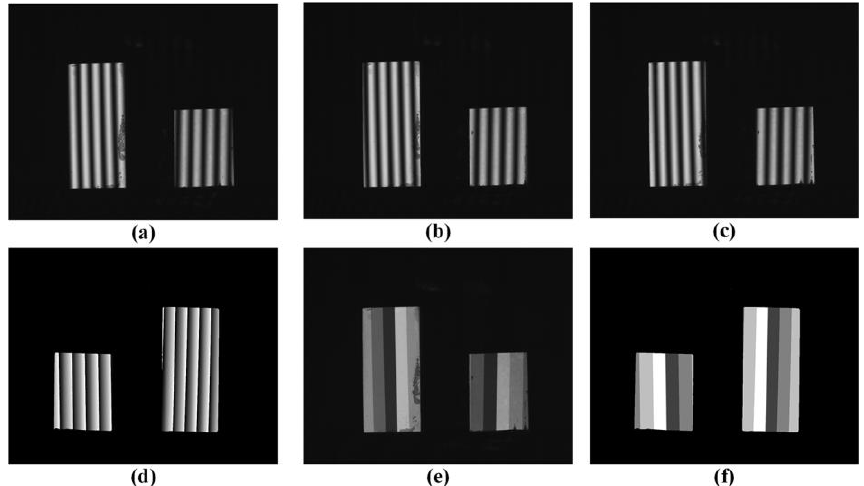
Figure 14. Images of two planes. ( a – c ) Phase-shift patterns; ( d ) wrapped phase map; ( e ) coded pattern; ( f ) code-word map.